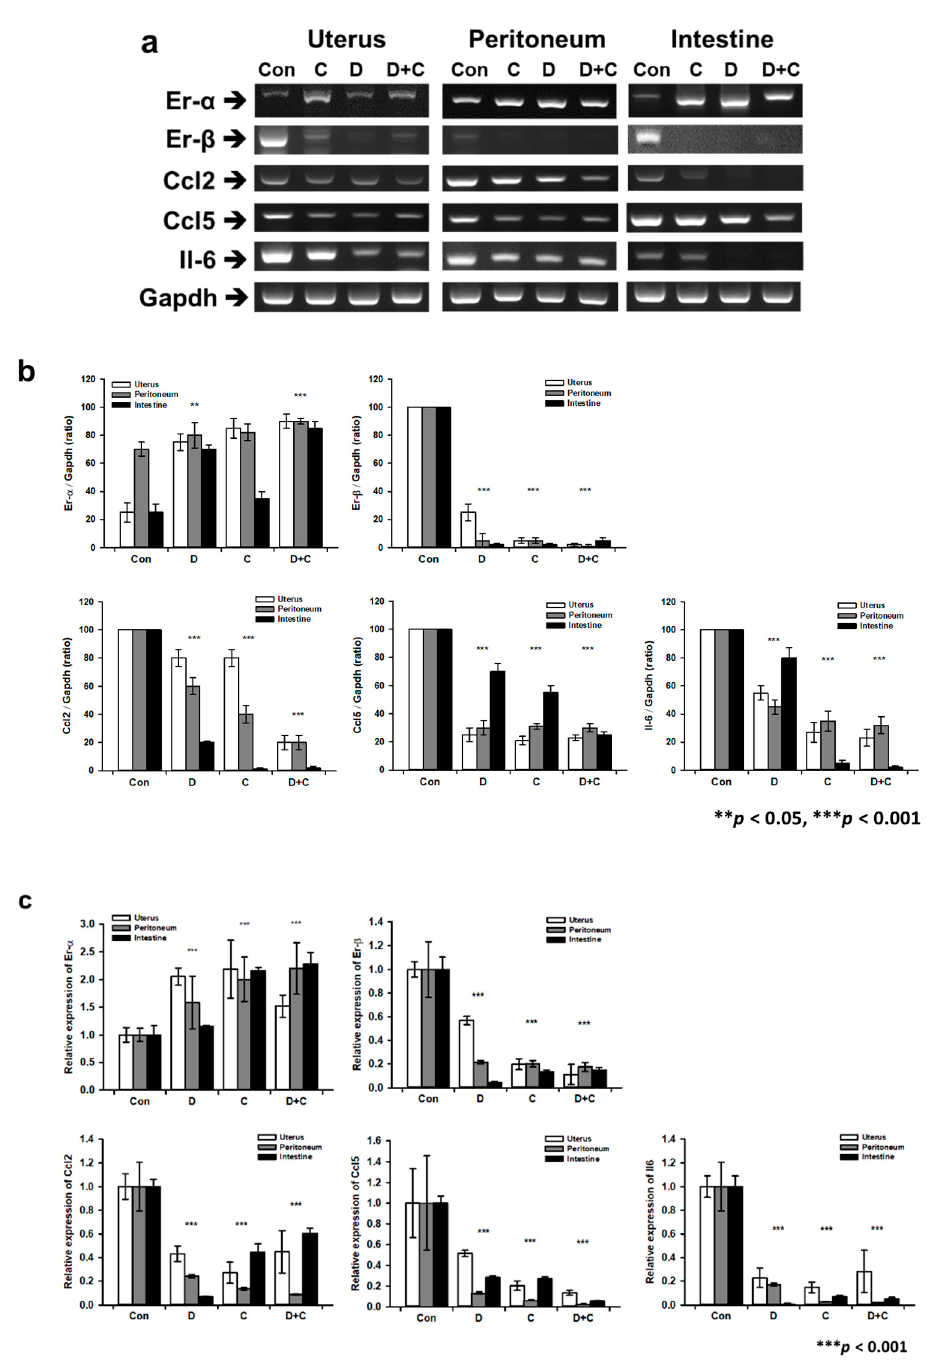
Figure 4. Analysis of gene expression in the inflammatory lesions of endometriosis tissue using RT-PCR (real-time polymerase chain reaction), ( a ) RT-PCR bands for Er- α , Er- β , Ccl (Chemokine ligand)2, Ccl5, and Il (Interleukin)-6 mRNA expression in the control and experimental groups (Dienogest, Cabergoline, and combined treatment). ( b ) Graph of RT-PCR product band intensity according to treatment in the experimental groups. ( c ) Graph of real-time qPCR with Er- α , Er- β , Ccl2, Ccl5, and Il-6 mRNA expression in the control and experimental groups (Dienogest, Cabergoline, and combined treatment). All experiments were repeated three times for statistical analysis (± SD, * p < 0.05, ** p < 0.01, and *** p < 0.001).